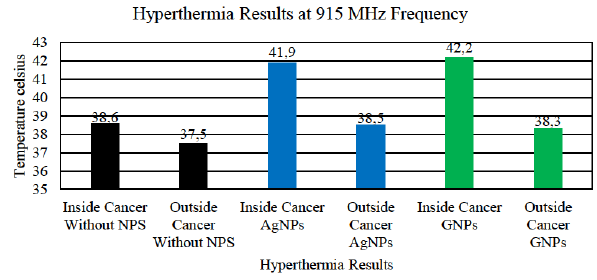
Figure 14: Compare results of hyperthermia at 915 MHz